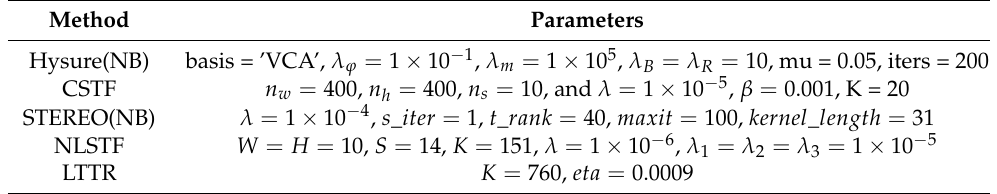
Table 2. Parameters of non-blind methods on the CAVE data